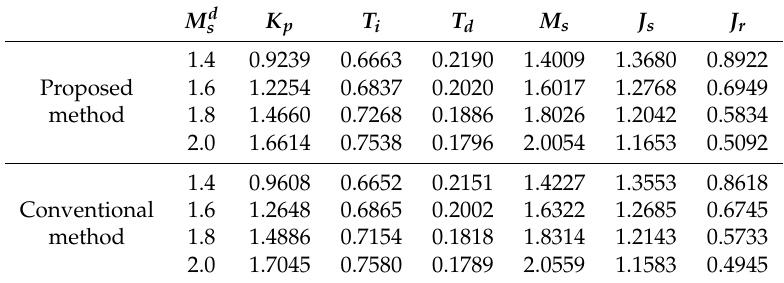
Table 7. Proportional-integral-derivative parameters, M s , and SAE values in the regulator design using Equation